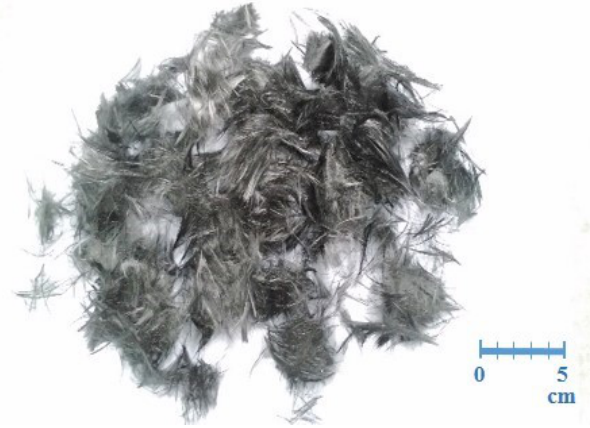
Figure 8. The SEM images of residual silane on short carbon fiber surface ( a ) unprocessed and using ( b ) water, ( c ) sodium hydroxide, ( d ) acetic acid, and ( e ) direct high-temperature heating.